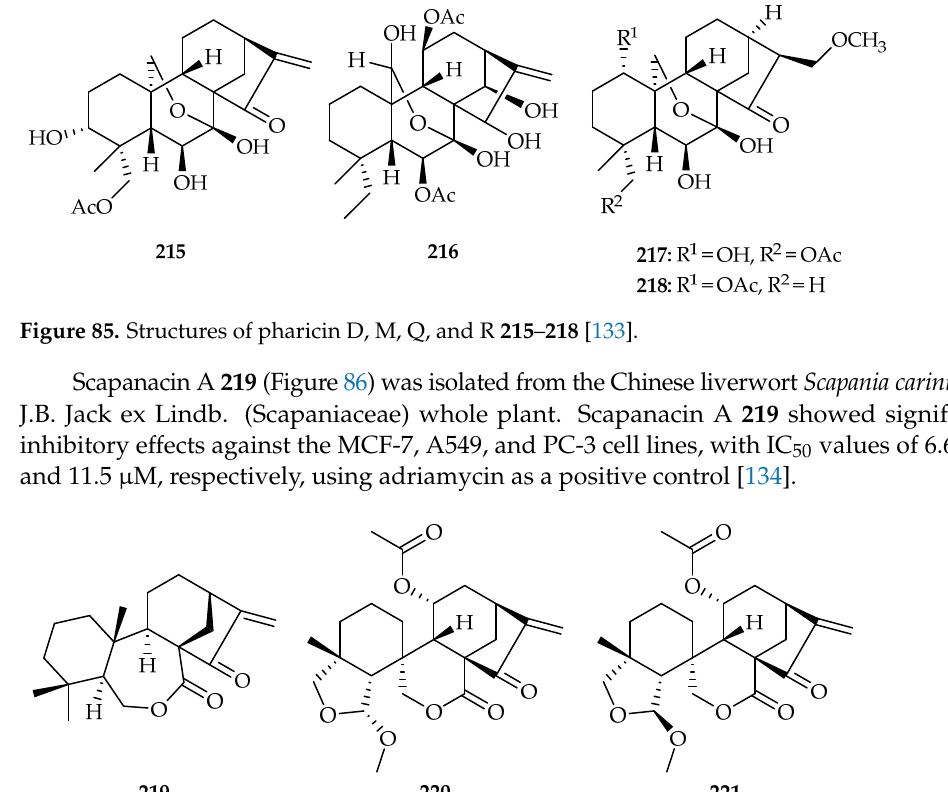
Figure 85. Structures of pharicin D, M, Q, and R 215–218 [133].